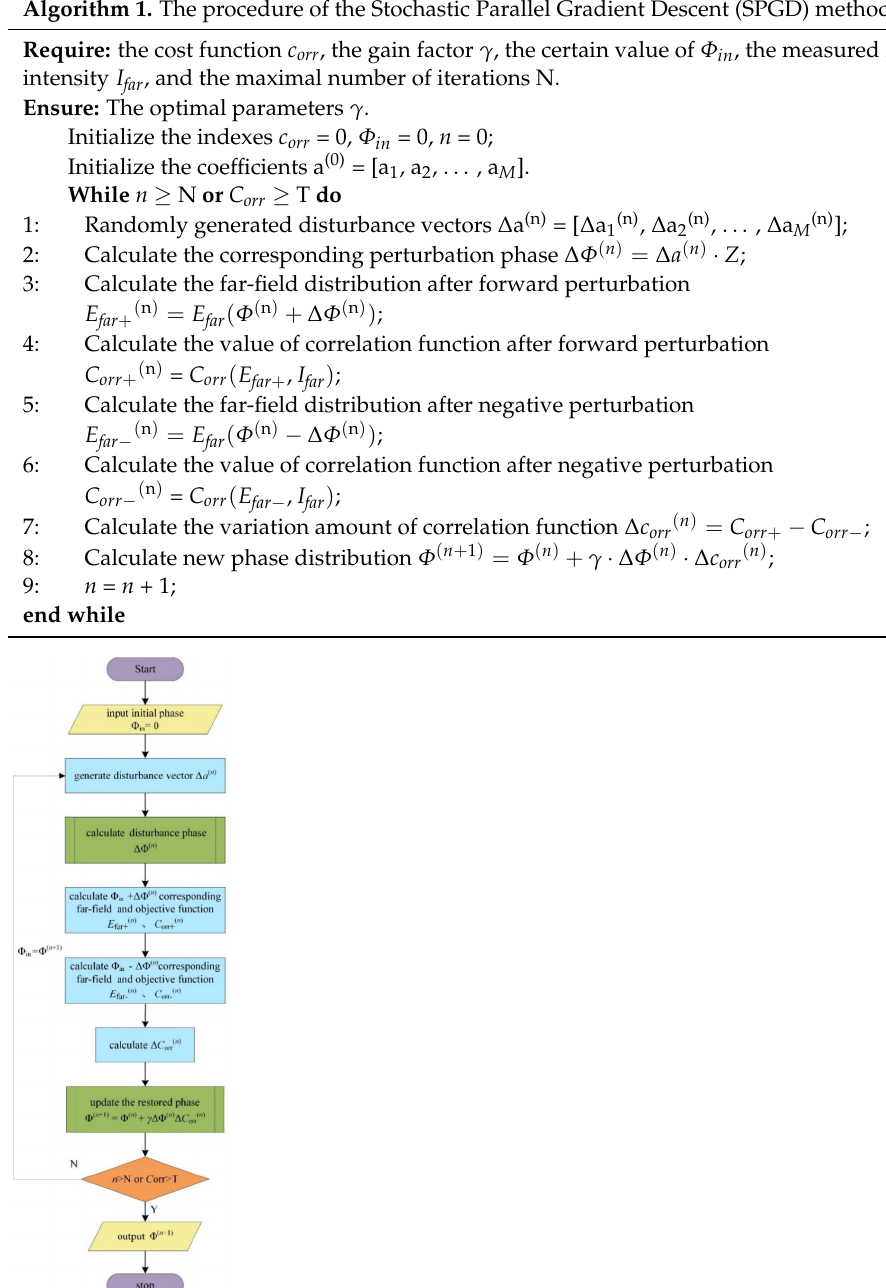
Algorithm 1. The procedure of the Stochastic Parallel Gradient Descent (SPGD) method